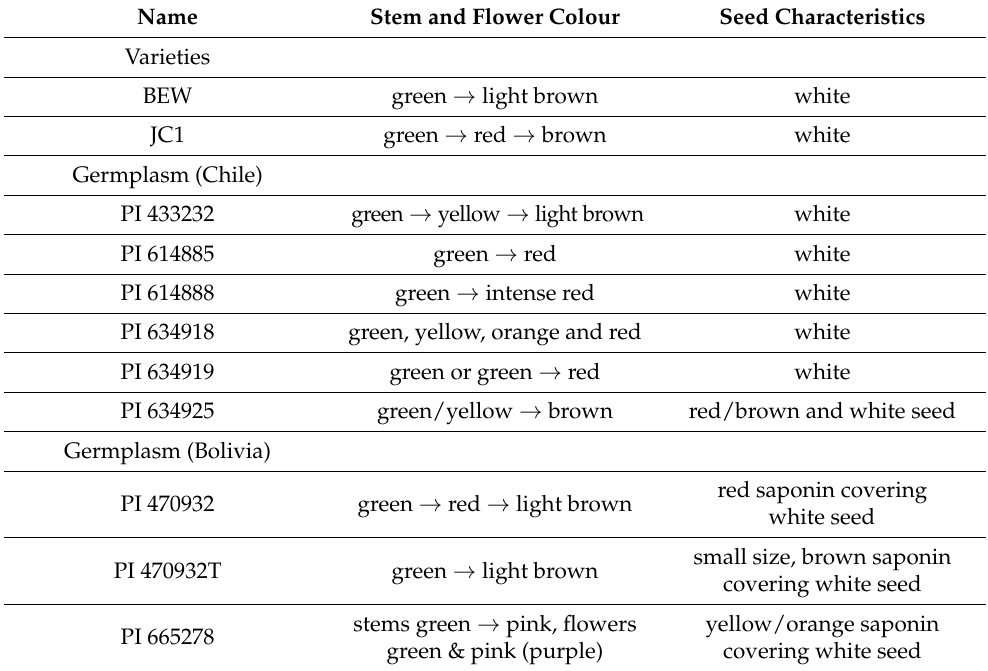
Table 4. Plant description of varieties and germplasm lines used in field trials (arrow indicates colour change as plants